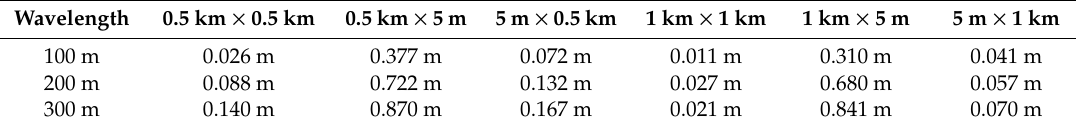
Table 13. The RMS of smoothing layover height inversion results with di ff erent wavelength (the direction of the smoothing window is in two directions at the same time, in the azimuth and in the